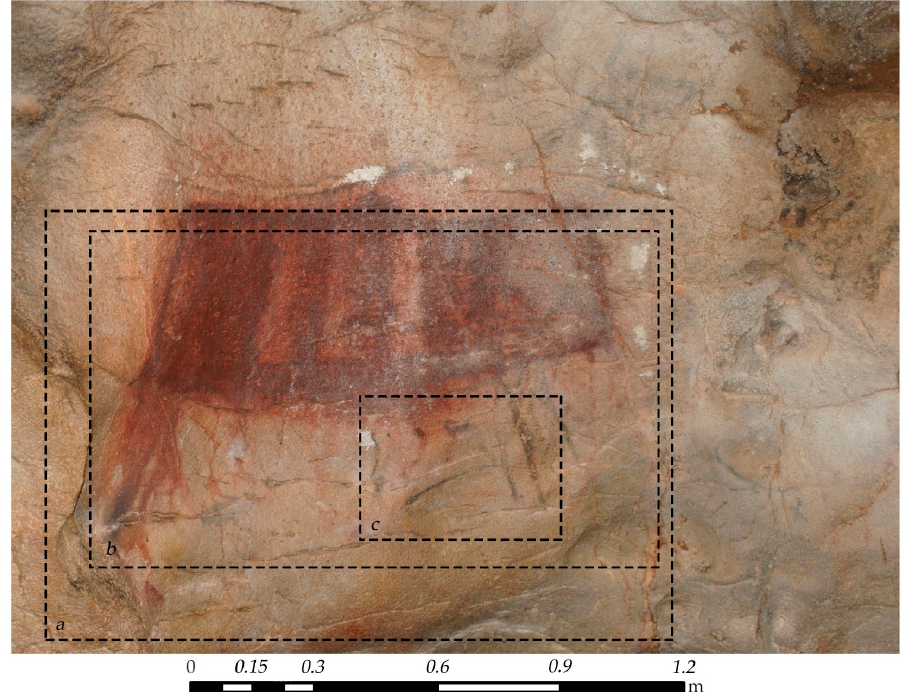
Figure 7. True color composition of hyperspectral image and location of the extension of figures. (a) represents the location of Figure 8, (b) represents the location of Figure 10.a and (c) represents the location of Figure 10.b (authorized by GIM Geomatics, S.L.).